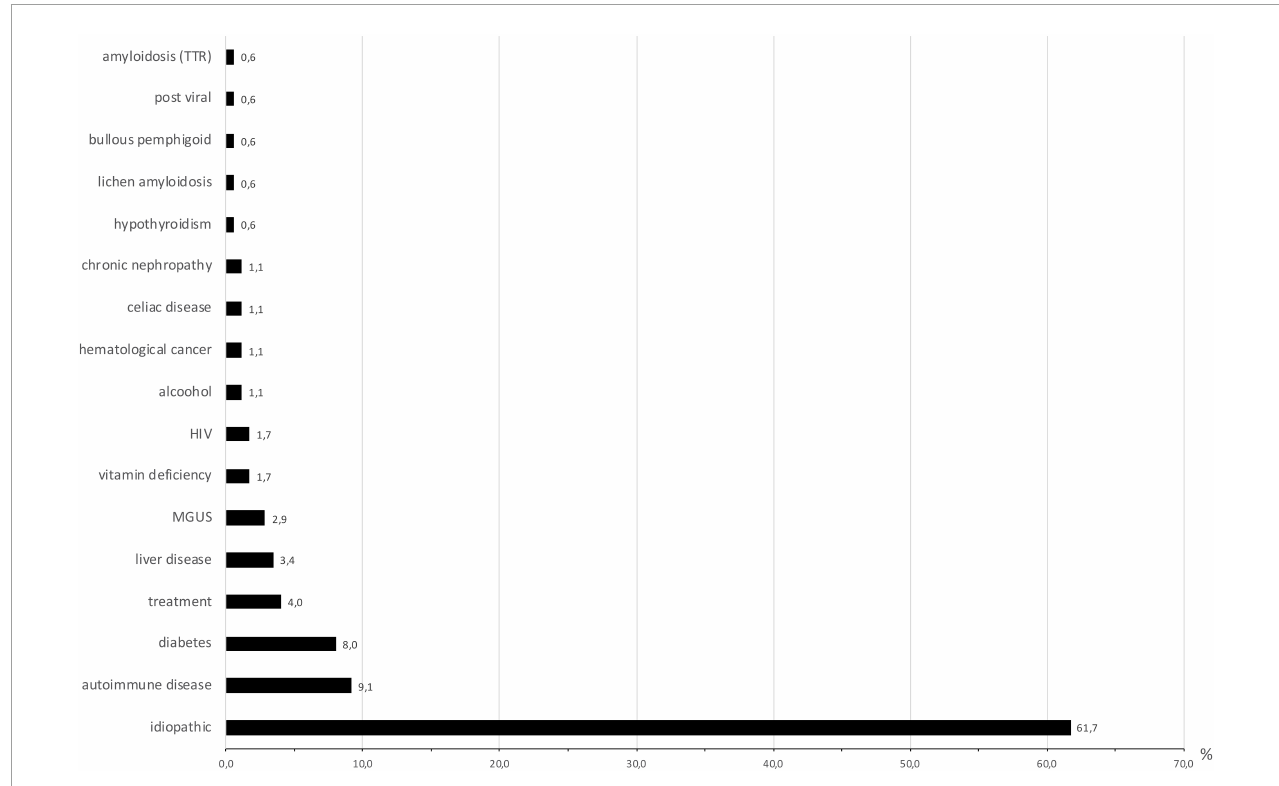
FIGURE1 Causes of small-fiber neuropathy (expressed in percentage). N = 175 because some patients had more than one cause identified. MGUS, monoclonal gammopathy of undetermined significance; HIV, human immunodeficiency virus; TTR, transthyretin.